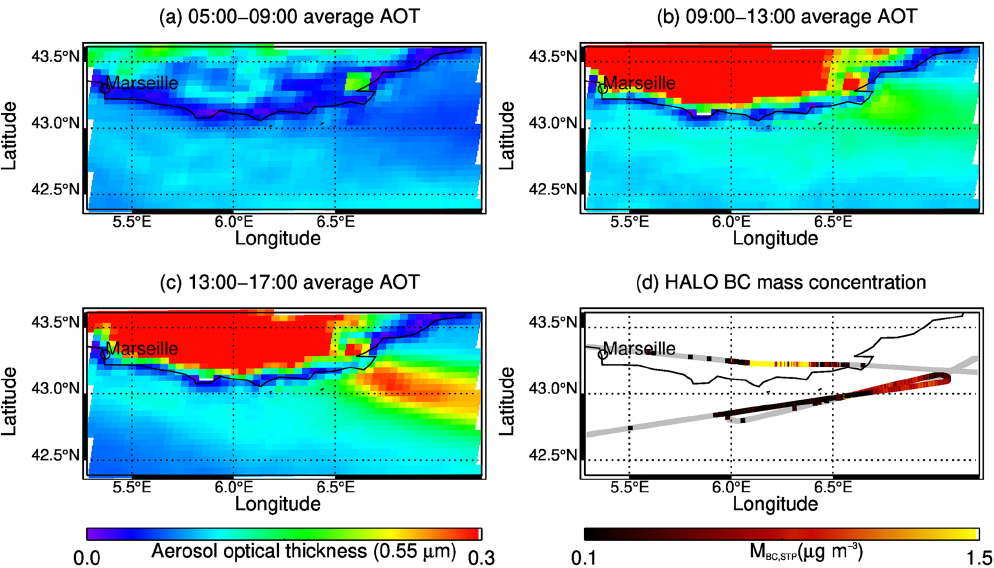
Figure 31. (a–c) Aerosol optical thickness at 0.55µm as retrieved from SEVIRI from 05:00 to 17:00UTC on 24 July 2017. (d) E-EU-07 flight track, colour coded with BC mass concentration (M BC ). For better contrast, the scale for M BC ranges from 0.1 to 1.5µgm − 3 . Grey colour on the flight track indicates values below 0.1µgm − 3 . The mass concentration reached values up to 7µgm − 3 at the French coast.